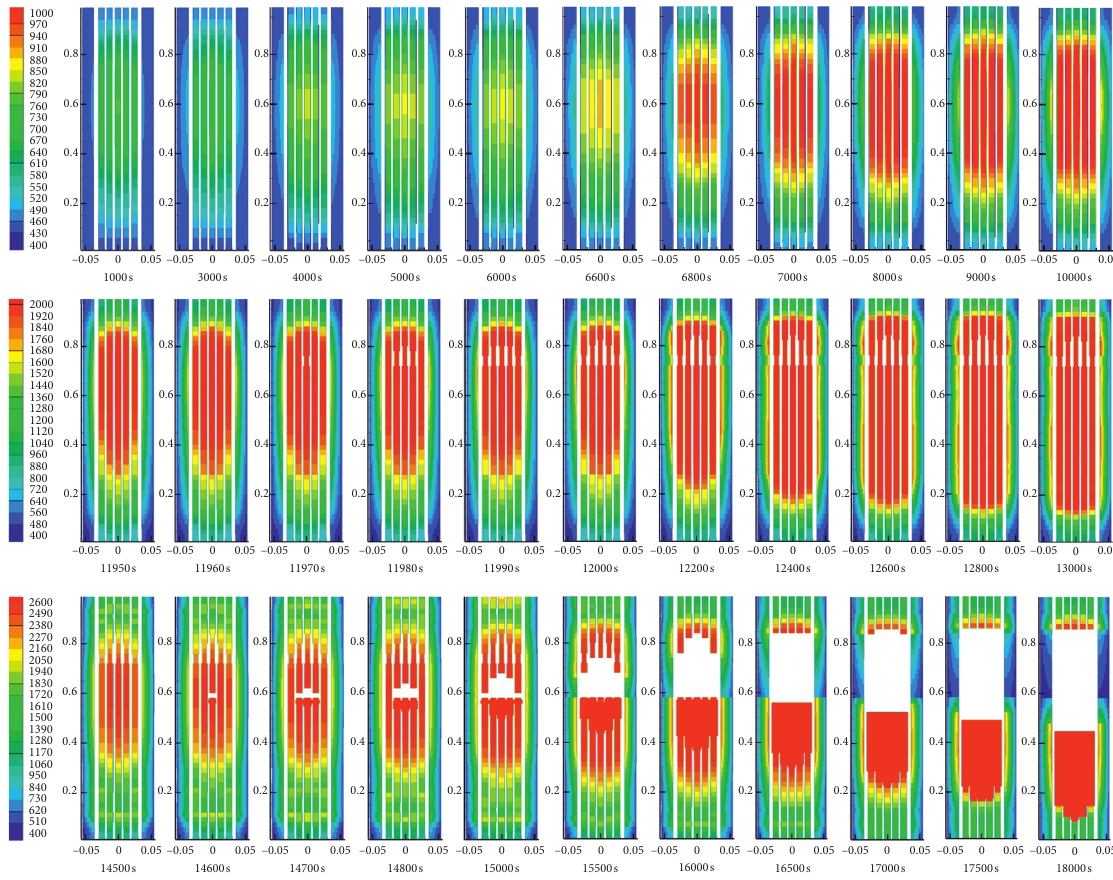
Figure 17: Temperature distribution along the height.